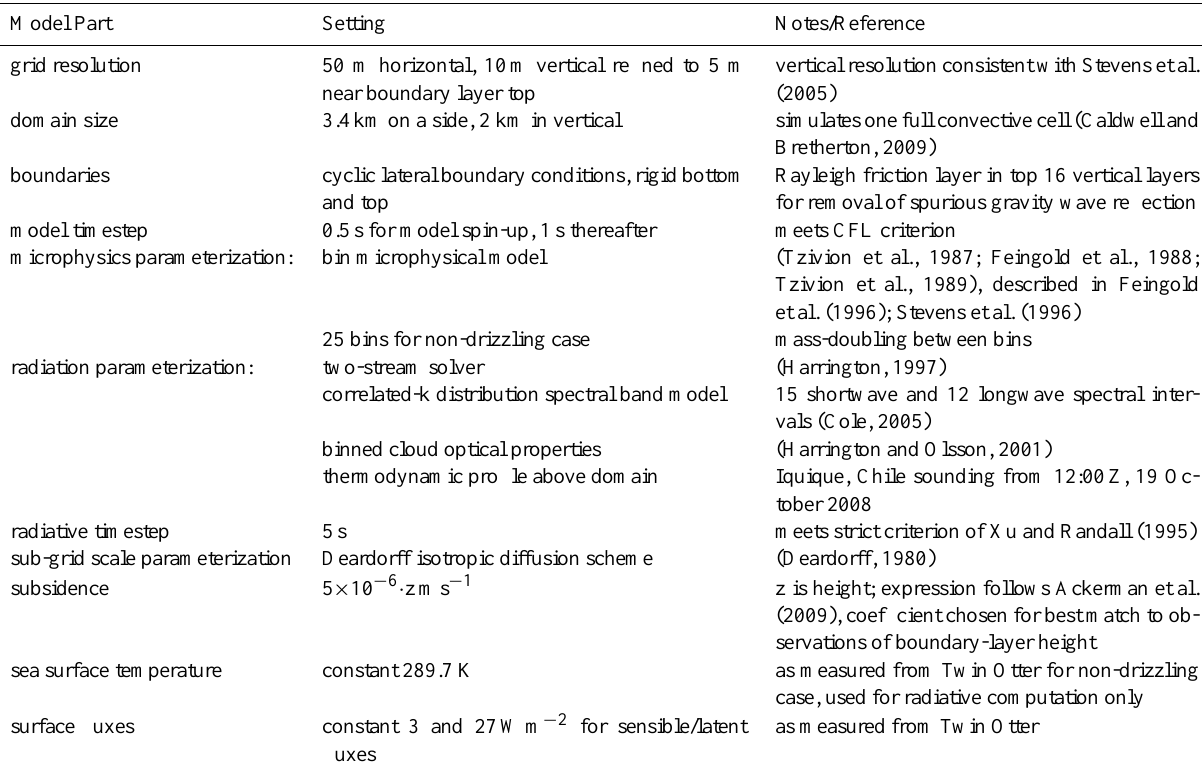
Table 1. Model base case configuration and settings for Regional Atmospheric Modeling System (RAMS) in large-eddy simulation. Where applicable, configuration values are based on in-situ observations from the Twin